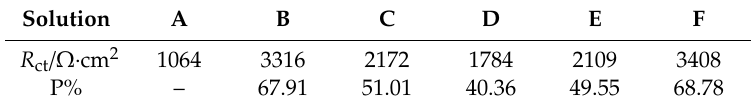
Figure 12. The Nyquist plots in 0.10 mol/L NaCl solutions at the E OCP of X70 carbon steel electrodes after 10 min anodic polarization at 0.500 V in α mol/L Na 3 PO 4 + β mol/L NaNO 2 solutions (A) α = 0.040, β = 0; (B) α = 0.030, β = 0.010; (C) α = 0.020, β = 0.020; (D) α = 0.010, β = 0.030; (E) α = 0, β = 0.040.